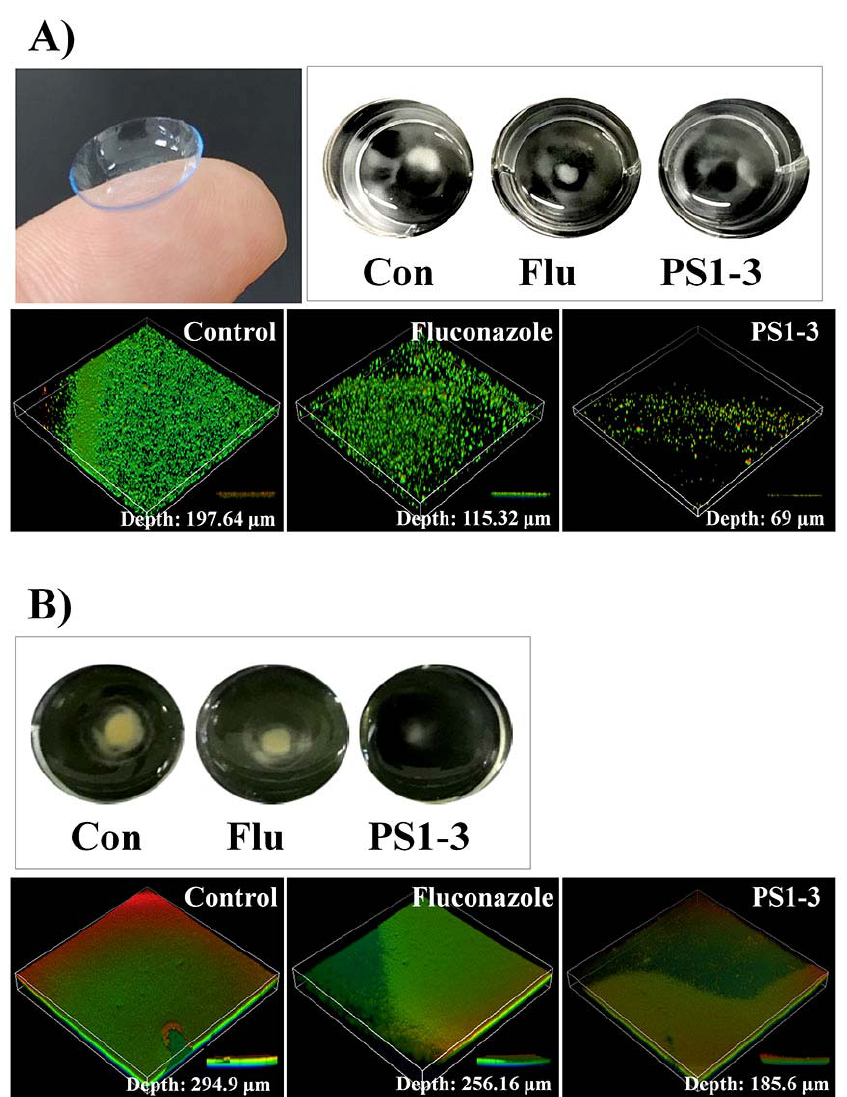
Figure 7. The visual effects of PS1-3 peptide against biofilm on the soft contact lenses (SCL). Biofilm inhibition ( A ) and reduction ( B ) in C. albicans CCARM 14007 cells following treatment with Fluconazole (128 µ M) and PS1-3 peptide (16 µ M).